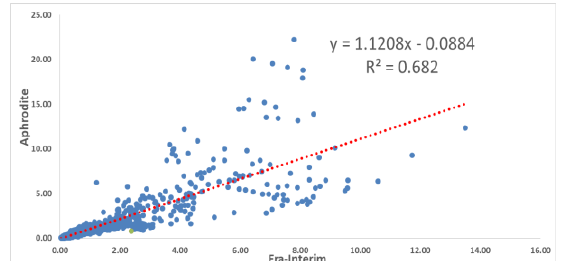
Figure 15. Scatter plot between daily rainfall in DJF season of Era-Interim and APHRODITE rainfall products